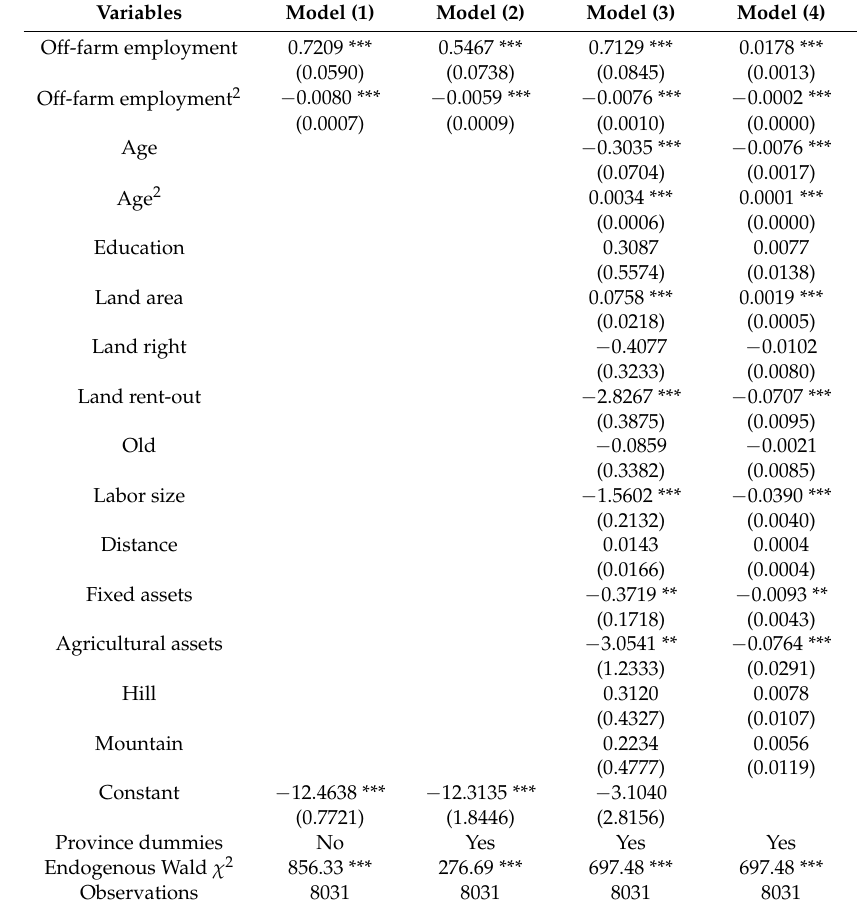
Table 3. The estimated result of IV-Tobit model and its marginal effect a